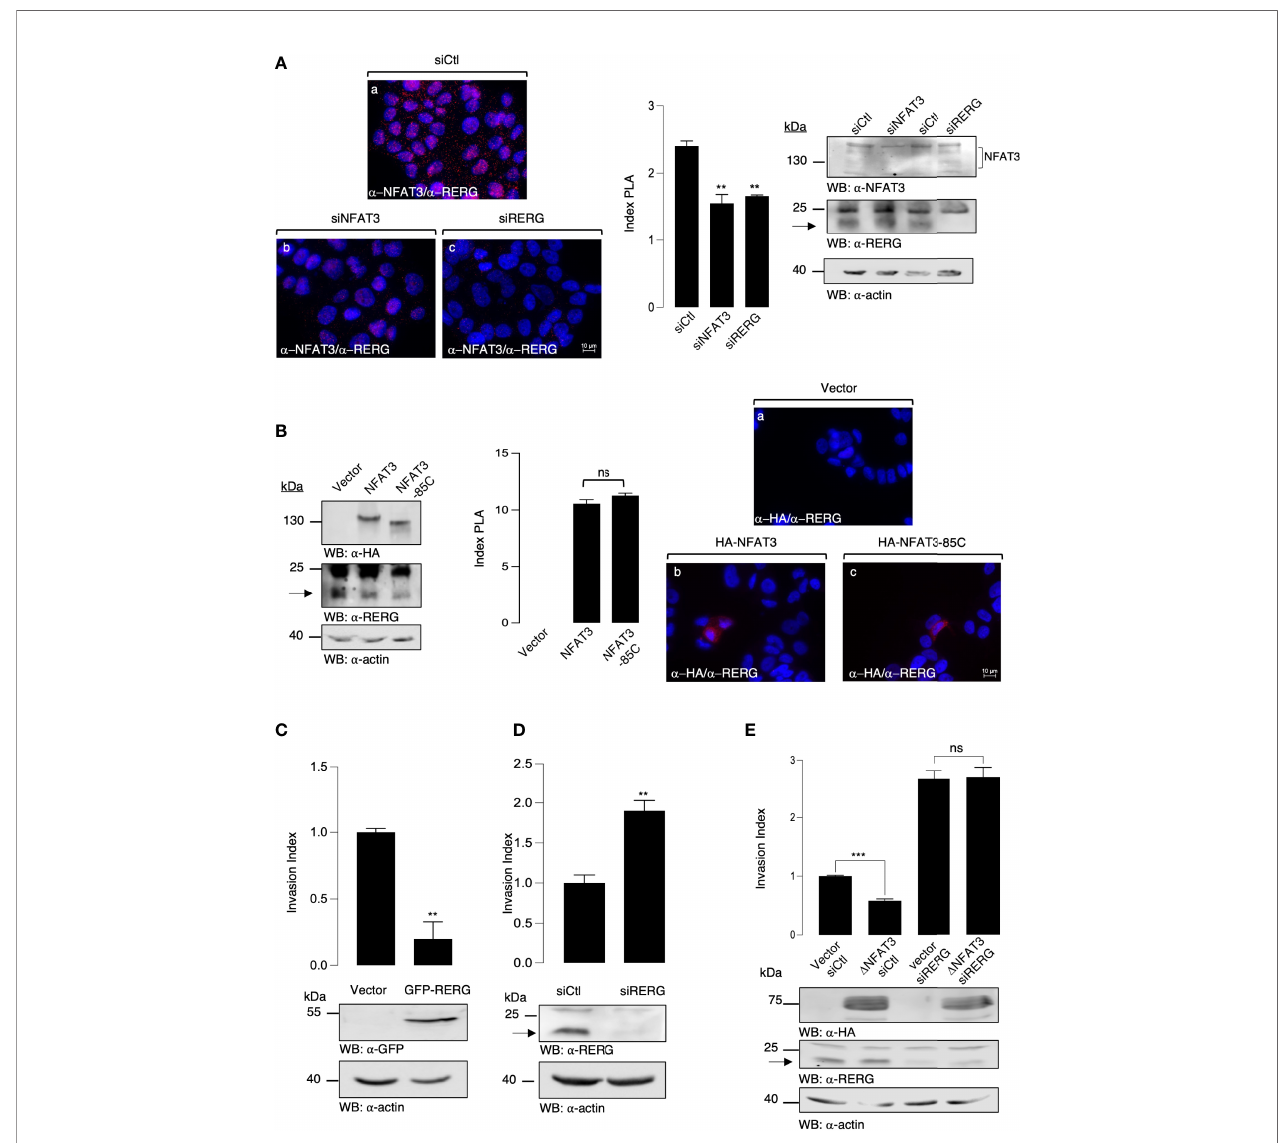
FIGURE 3 | NFAT3 is associated with RERG in T-47D cells to suppress breast cancer cell invasion. (A) T-47D cells were grown on coverslips and transfected with either an siRNA control (siCtl), a siRNA targeting the endogenous NFAT3 (siNFAT3), or the endogenous RERG (siRERG). Approximately 48 h after transfection PLA assays were performed on the transfected cells with the anti-NFAT3 and the anti-RERG ( a -NFAT3/ a -RERG) (a-c). Index of PLA was obtained by analyzing ten random fi elds for each condition, all data are shown as the mean of three independent experiments ± SEM (n=3 biological replicates; 3 technical replicates for each experiment; **p<0.005, ***p<0,001, ns, nonspeci fi c). Whole cell lysates were revealed by a -NFAT3 and a -RERG and normalized by comparison with an a - actin. (B) T-47D cells were grown on coverslips and transfected with either the empty vector or a vector encoding the HA epitope fused to either NFAT3 or NFAT3- 85C. Approximately 24 h after transfection, PLA assays were performed on the transfected cells with the a -HA and a -RERG (a-c). Index of PLA was obtained by analyzing fi fteen random fi elds for each condition; all data are shown as the mean of three independent experiments ± SEM (n=3 biological replicates; 10 random fi elds for each condition; ns = non-speci fi c). Whole cell lysates were revealed by a -HA and a -RERG and normalized by revelation with an a -actin. (C) T-47D cells were transiently transfected with either a vector encoding the GFP protein fused to RERG or with the empty vector (Vector). The following day, transfected